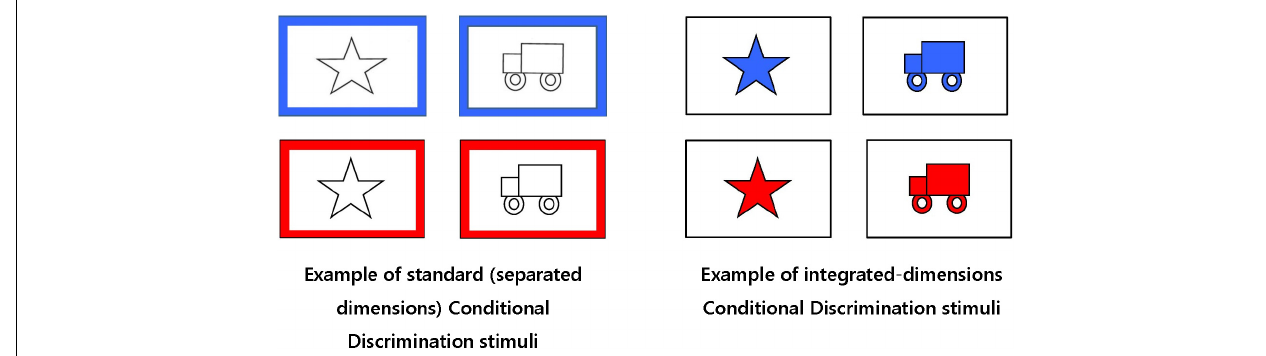
FIGURE 1 | Examples of Standard (Separated Dimensions) and Integrated-Dimensions Conditional Discrimination Stimuli used in this study.